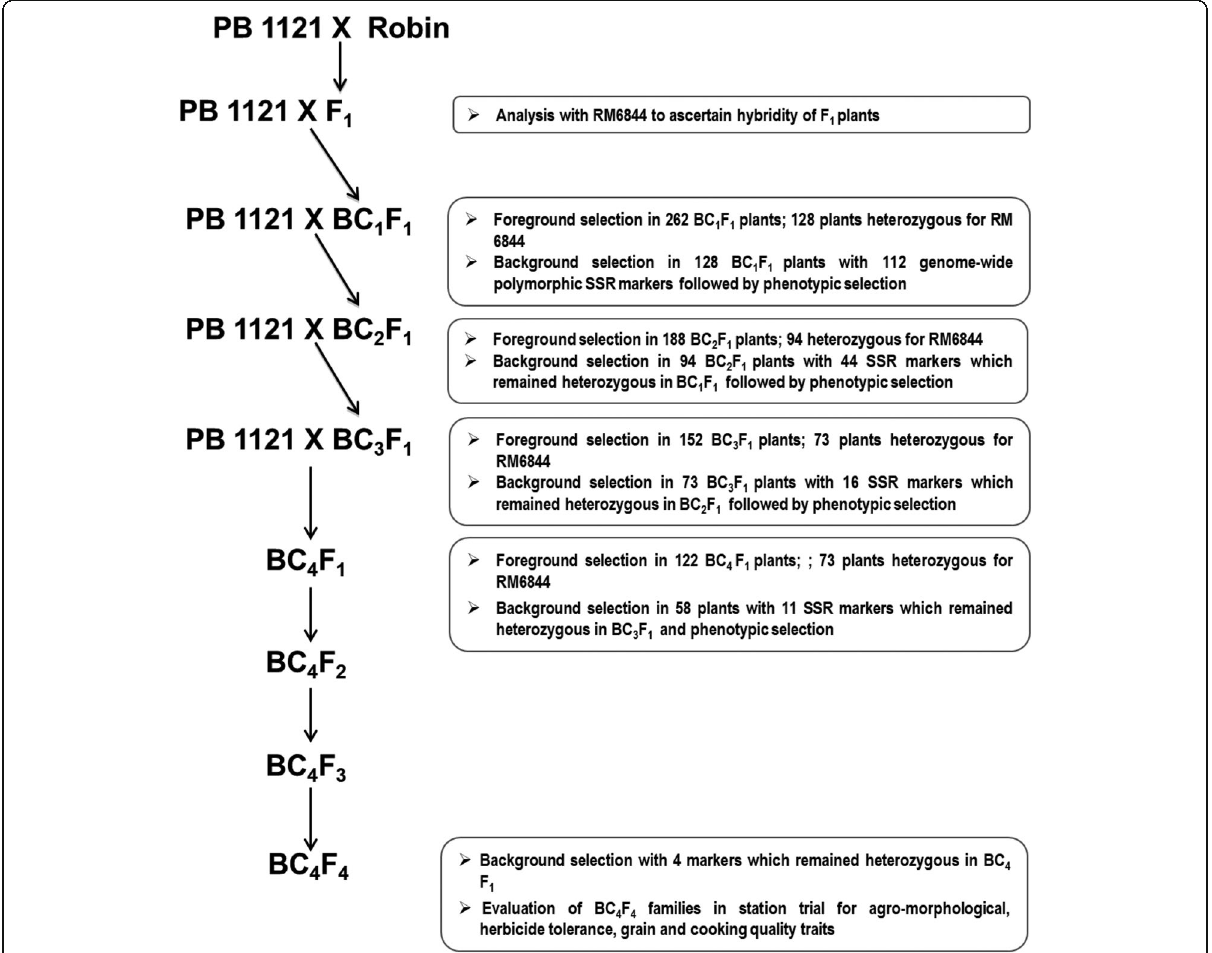
Fig. 1 Marker aided backcross breeding strategy used for transferring the herbicide tolerance trait into PB